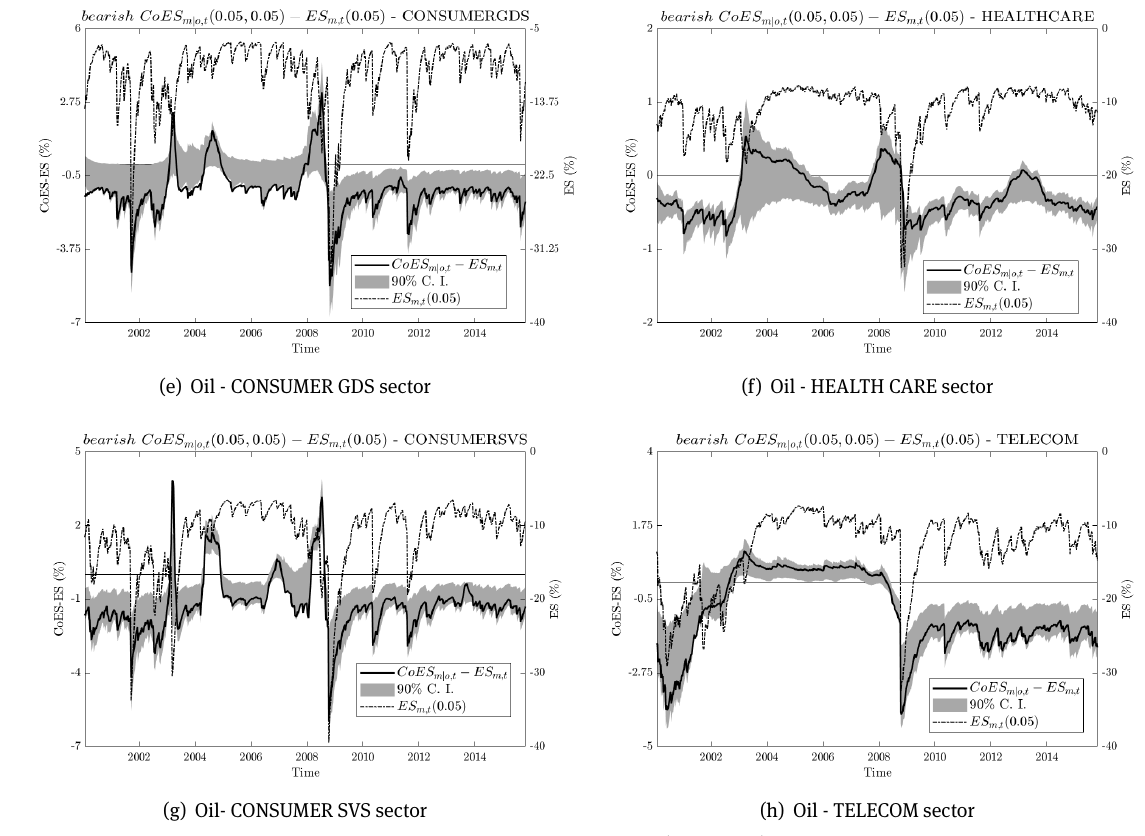
Figure 18b: CoES m | o , t (0.05, 0.05) for a certain sector given a bearish scenario for oil